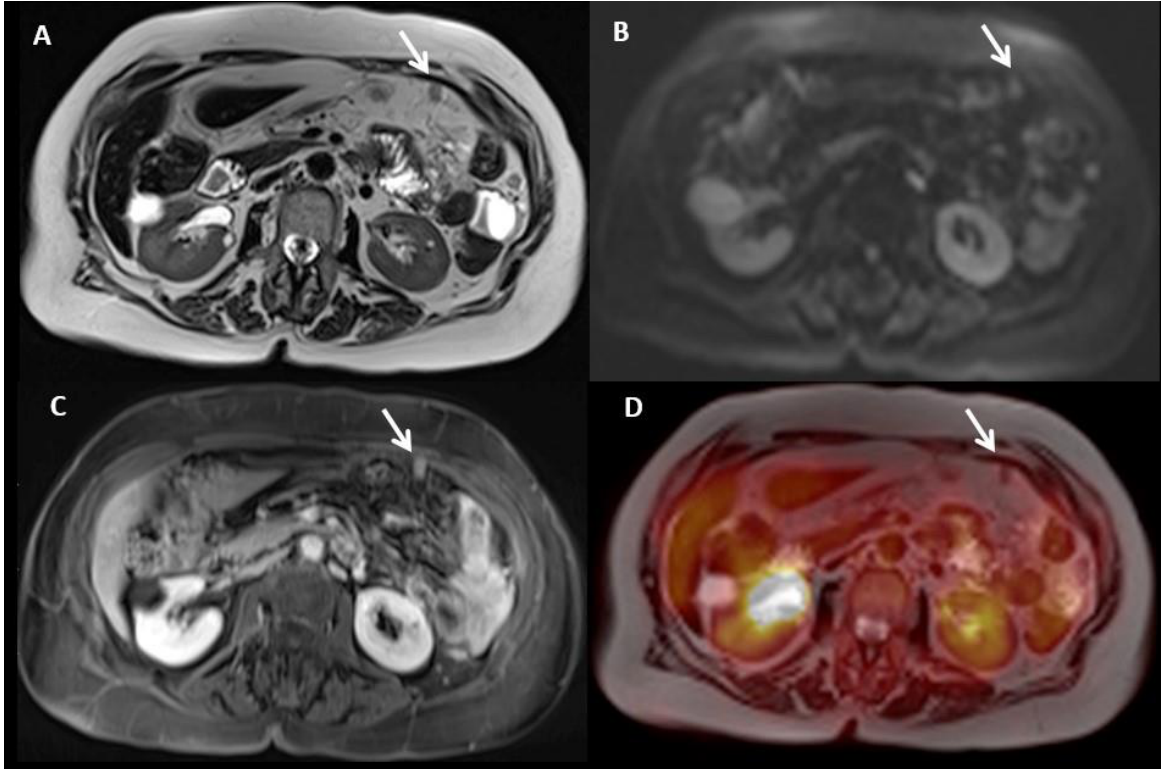
Figure 15. A 69-year-old female patient with peritoneal carcinomatosis from diffuse-type gastric cancer, including a 2 cm lesion located in the greater omentum. Lesion was visible (arrows) on T2WI ( A ), DWI ( B ), and contrast-enhanced T1WI ( C ) and was negative on PET ( D ).